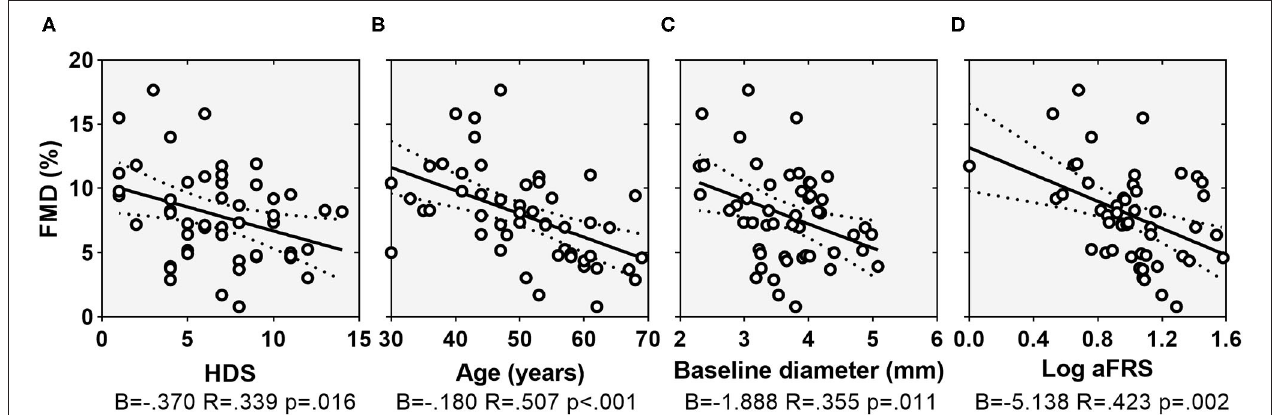
FIGURE 1 | Scatterplots showing the relationship between FMD and HDS (A) , age (B) , baseline arterial diameter (C) , and Log(aFRS) (D) . Dotted lines indicate 95% confidence interval. FMD, flow-mediated dilation; HDS, depression subscale of the Hospital Anxiety and Depression Scale; aFRS, adjusted Framingham risk score.